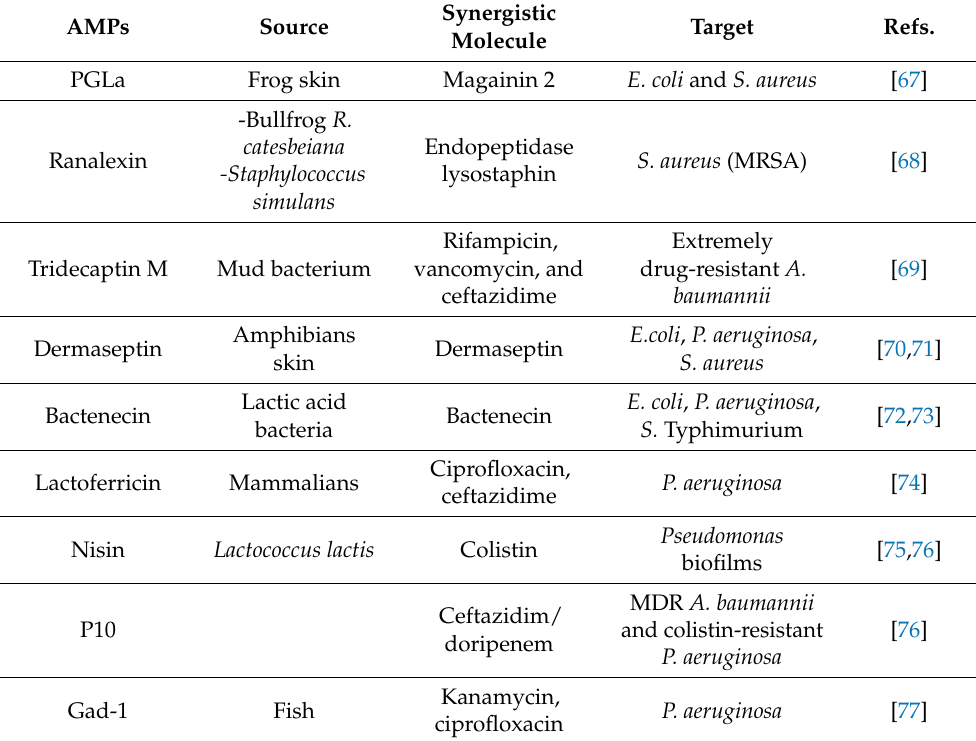
Table 1. Properties of AMPs showing synergistic activities with one another and/or with